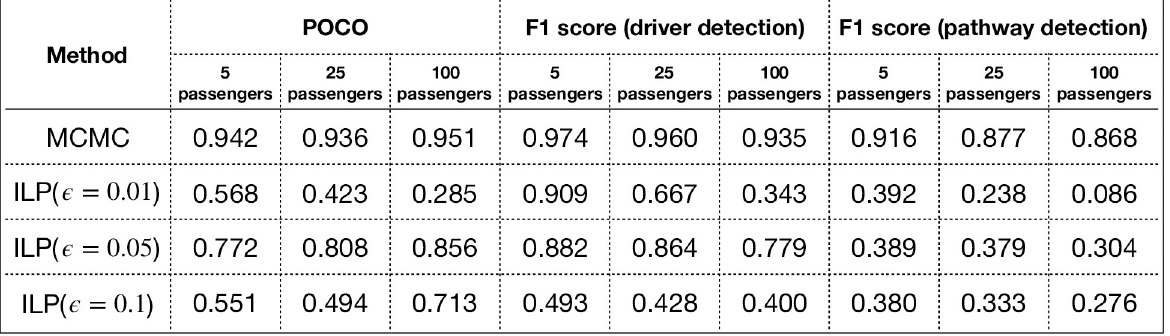
Fig 5. POCO, F1 scores for driver detection and F1 scores for specific pathway detection (averaged over pathway 1 to 5) in Experiment 2.